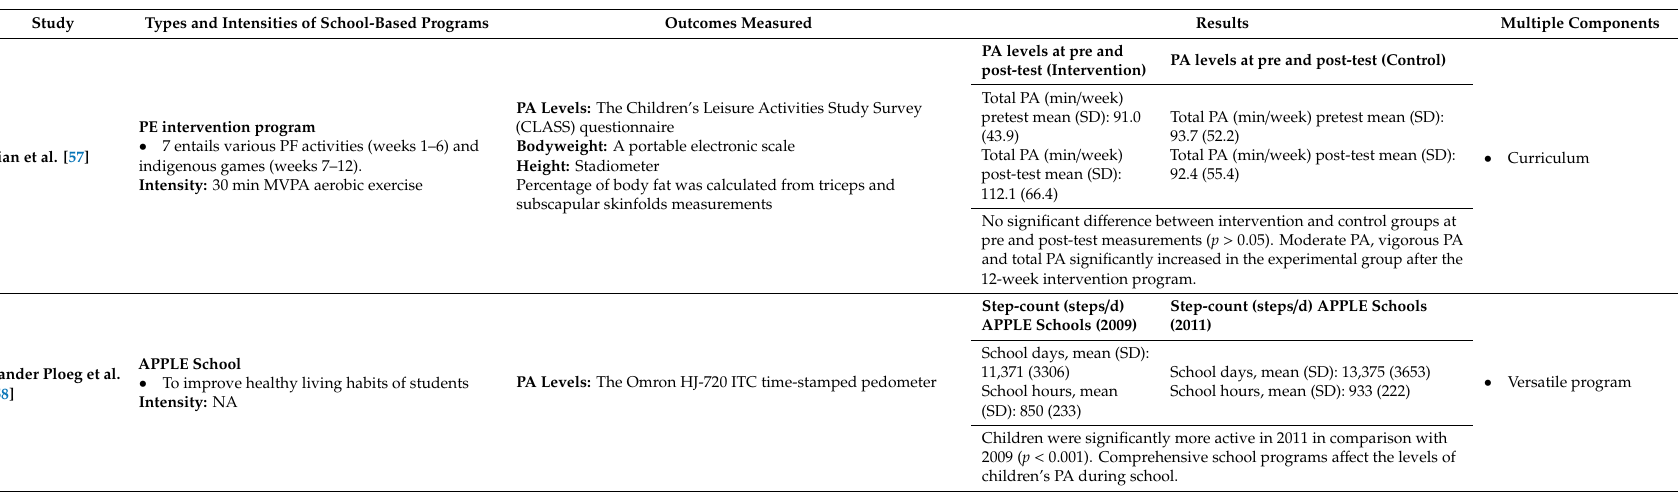
PA levels at pre and post-test (Intervention) PA levels at pre and post-test (Control)